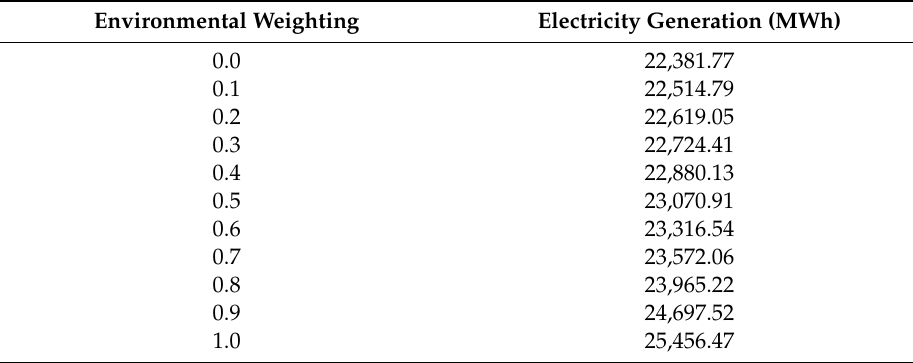
Table A3. Total electricity generation depending on environmental weighting.